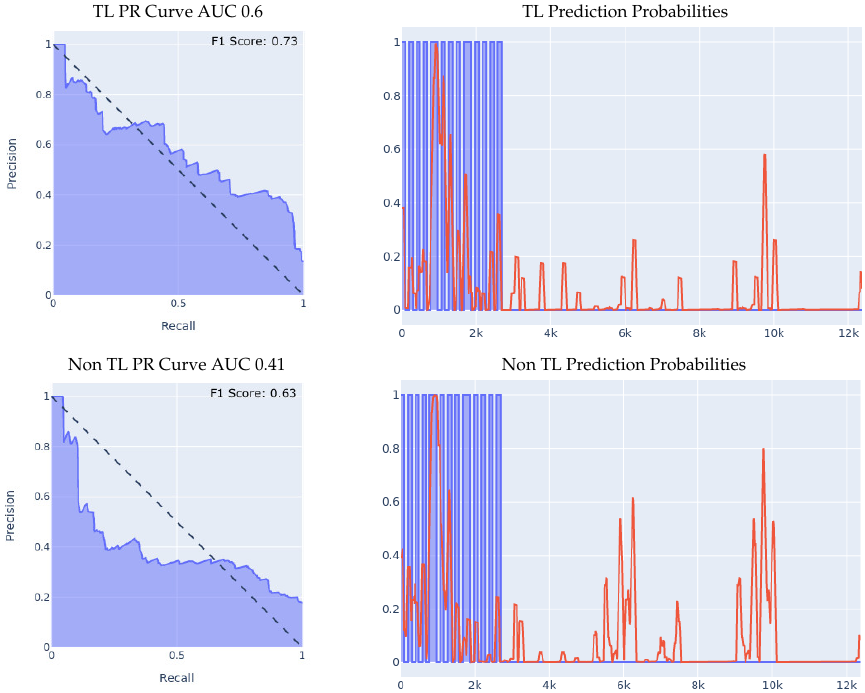
Figure 6. Leave-one-person-out data split experiment for meta-sensor. For prediction probabilities, x axis is the time, y axis is the prediction threshold, blue data is the real labels, red data is the prediction probabilities. For the F1 Scores, the averaged F1 score of all the 8 iterations of the cross-validation is shown in the top right corner of the PR